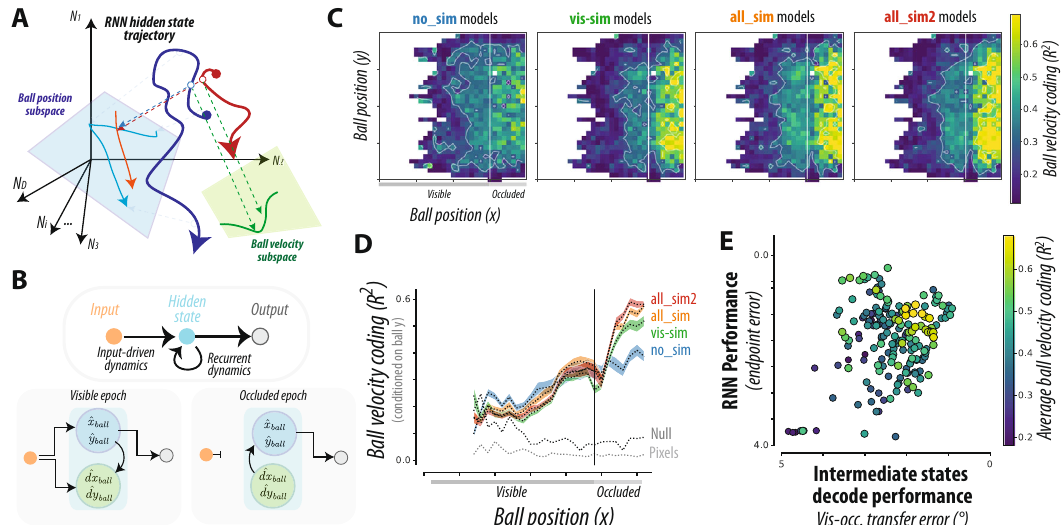
Fig. 5 | Dynamics underlying computations performed by RNNs. A Conceptual schematic. Schematic of RNN hidden state trajectory for two hypothetical condi- tions (dark blue, dark red) during the occluded epoch. To accurately perform dynamic inference, a projection (illustrated in cyan) of each RNN hidden state trajectory must approximately correspond to the latent time-varying position of theball[x,y](hereillustratedinlightblue,lightred).However,duringtheoccluded epoch, RNNs are autonomous nonlinear dynamical systems, wherein the hidden statesevolveovertimebasedonrecurrentcomputationsalone.Thus,wereasoned that RNN states additionally encode the ball velocity (green projection). B To produce different hidden state trajectories for different conditions, the RNN hid- den state trajectories must be fl exibly controlled by their initial conditions. Thus, we reasoned that RNNs must estimate both ball position and velocity from the sensory input during the visible epoch (left) and maintain ball velocity estimate throughout the occluded epoch to autonomously update the ball position (right). C Eachpanelshows a heatmap of the M-Pong frame, with colorscorresponding to